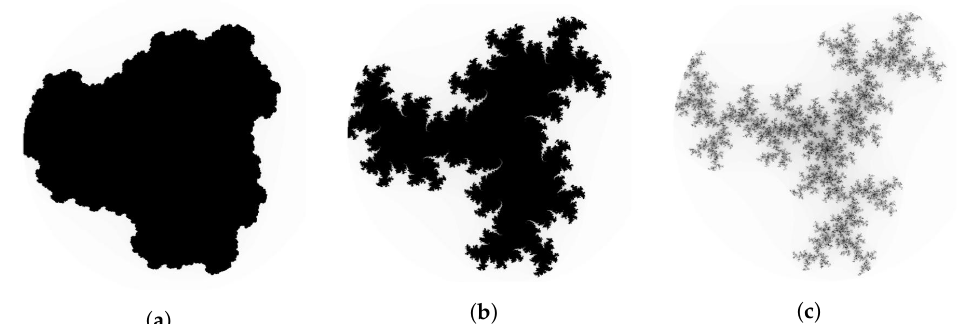
Figure 7. Julia sets that appear differently depending on offset at S S 4,0.9,0.1 ( x ,3 ) iterating 128-times. ( a ) S S 4,0.9,0.1 ( x ,3 ) , c = 0.66750000 − 0.3250000 i ; ( b ) S S 4,0.9,0.1 ( x ,3 ) , c = 0.85500000 − 0.60000 i ; ( c ) S S 4,0.9,0.1 ( x ,3 ) , c = 0.840000 − 0.990000 i